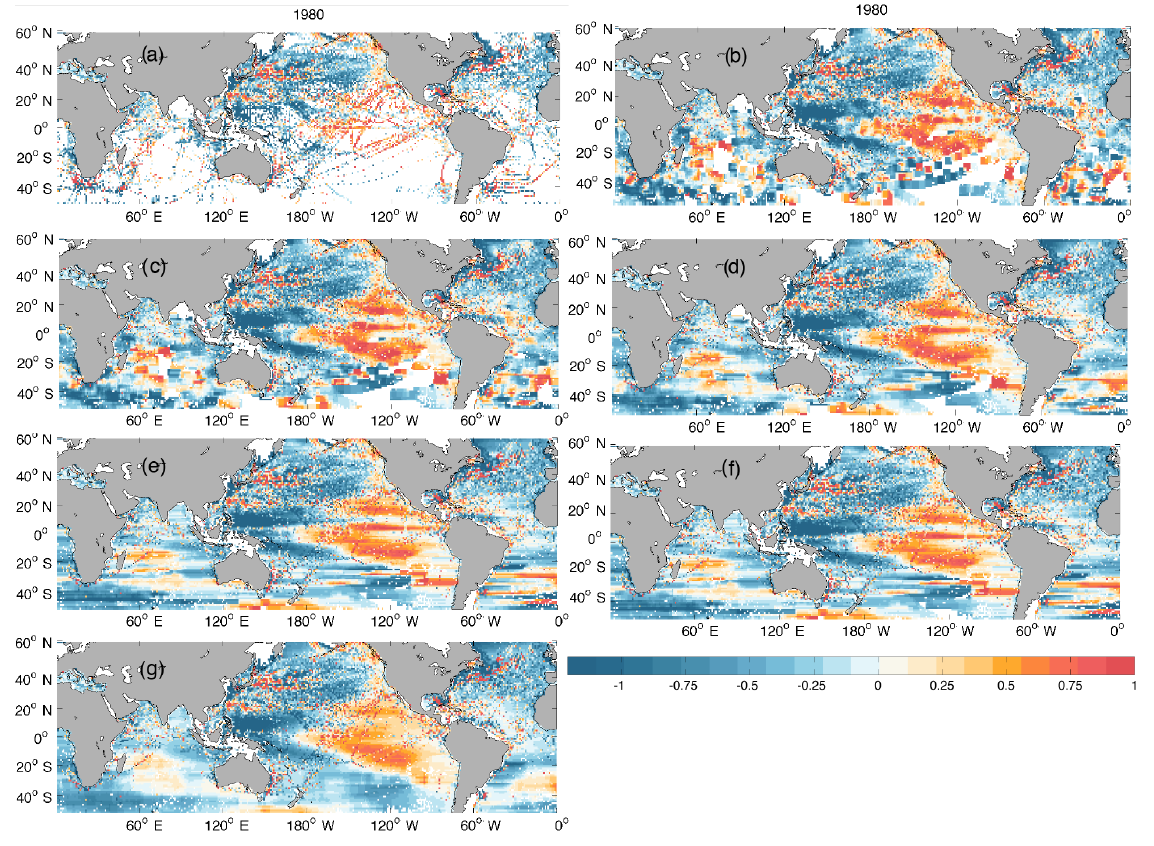
Figure 1. Flexible-grid method. (a) shows the geographical distribution of 700m OHC in 1980 on each 1 ◦ by 1 ◦ grid, showing good data coverage in the Northern Hemisphere and sparse data in the Southern Hemisphere. To fill these data gaps by using the flexible-grid method, OHC on each grid in the poorly sampled region (defined as the Argo-Ship Area in CZ14) is calculated by averaging OHC on a large latitude– longitude grid with sizes of 5 ◦ by 5 ◦ , 5 ◦ by 10 ◦ , 5 ◦ by 20 ◦ , 1 ◦ by 40 ◦ , 8 ◦ by 40 ◦ , and 10 ◦ by 40 ◦ separately. The resultant OHC distribution is shown from (b) to (g)